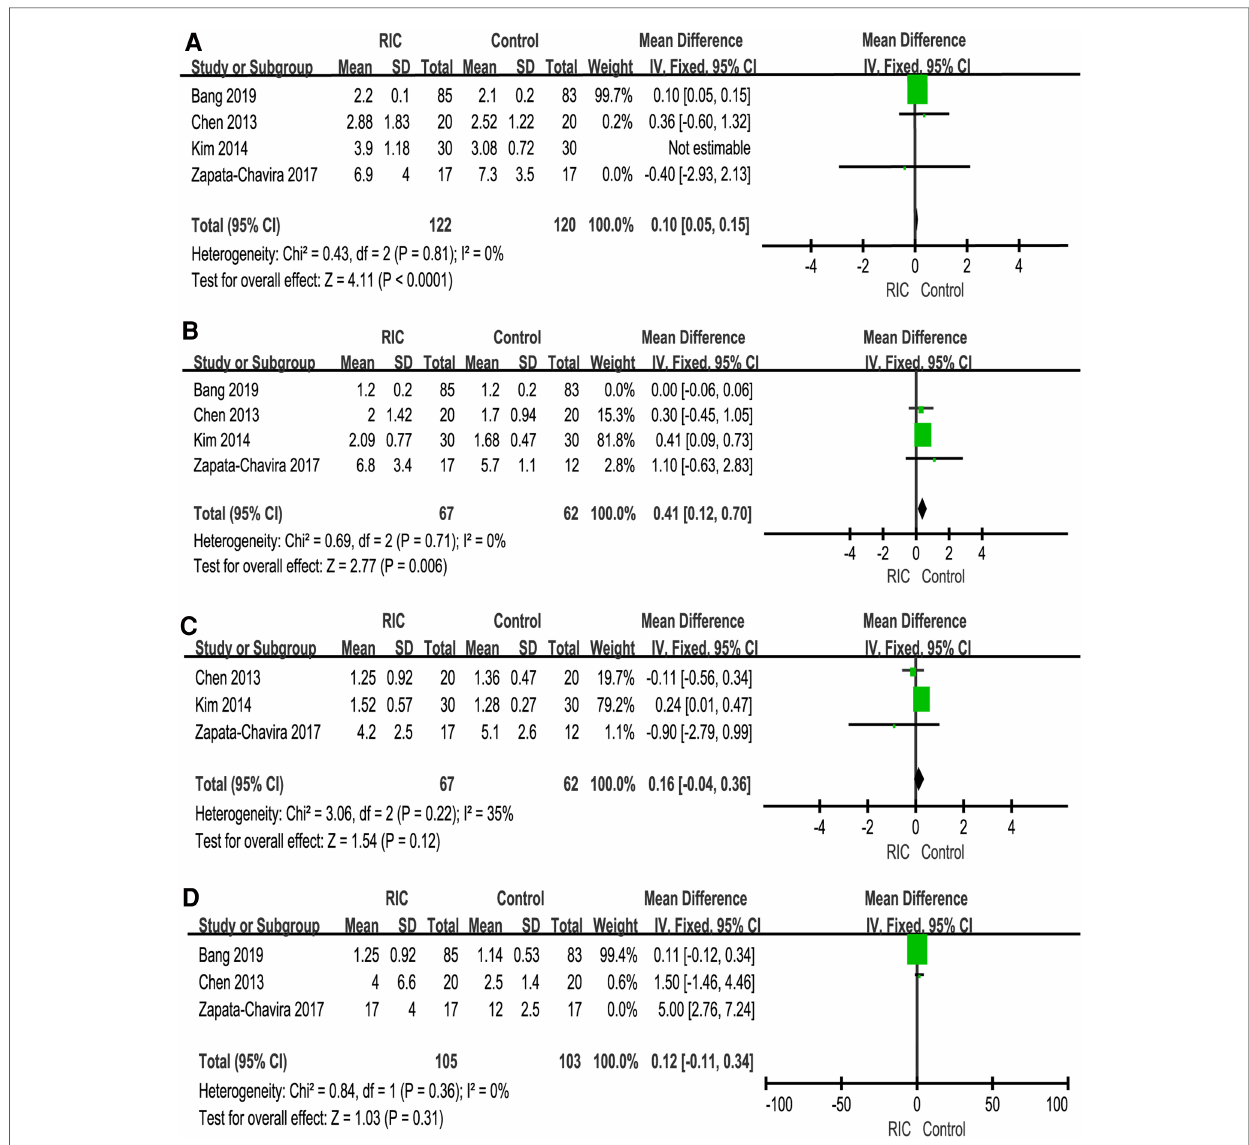
FIGURE 4 Forest plot with 95% con fi dence interval in serum creatinine (Scr), Scr levels at 1 day postoperatively ( A ), Scr levels at 2 days postoperatively ( B ), Scr levels at 3 days postoperatively ( C ), Scr levels at 7 days postoperatively ( D ). RIC, remote ischemic